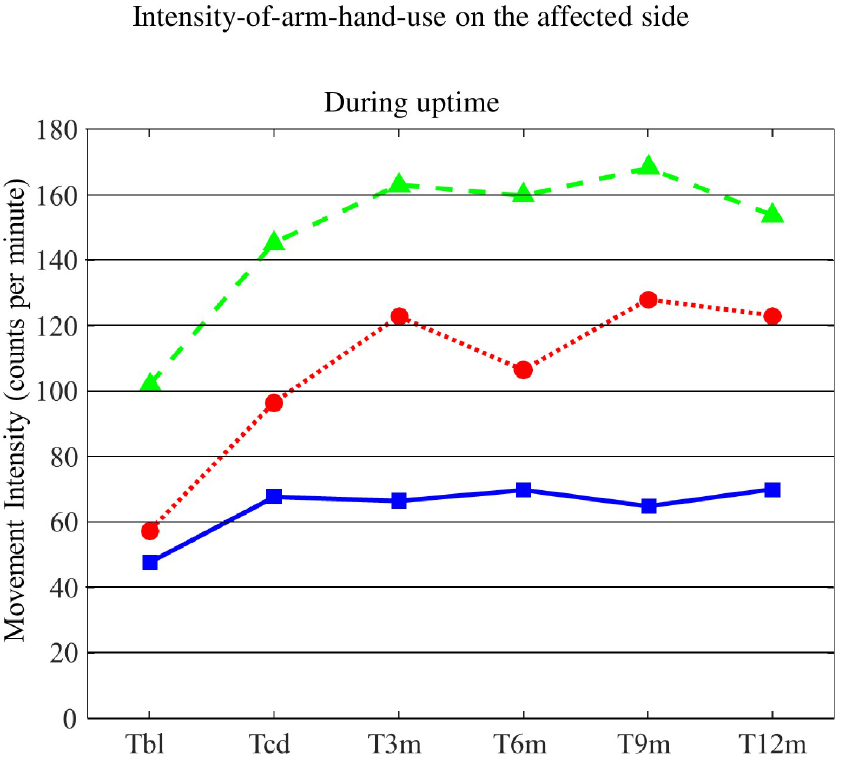
Fig 3. Mean values for Intensity-of-arm-hand-use during uptime for subgroups 1, 2 and 3. T = time; bl = baseline; cd = clinical discharge; m = month; Solid line = subgroup 1; Dotted line = subgroup 2; Dashed line = subgroup 3.